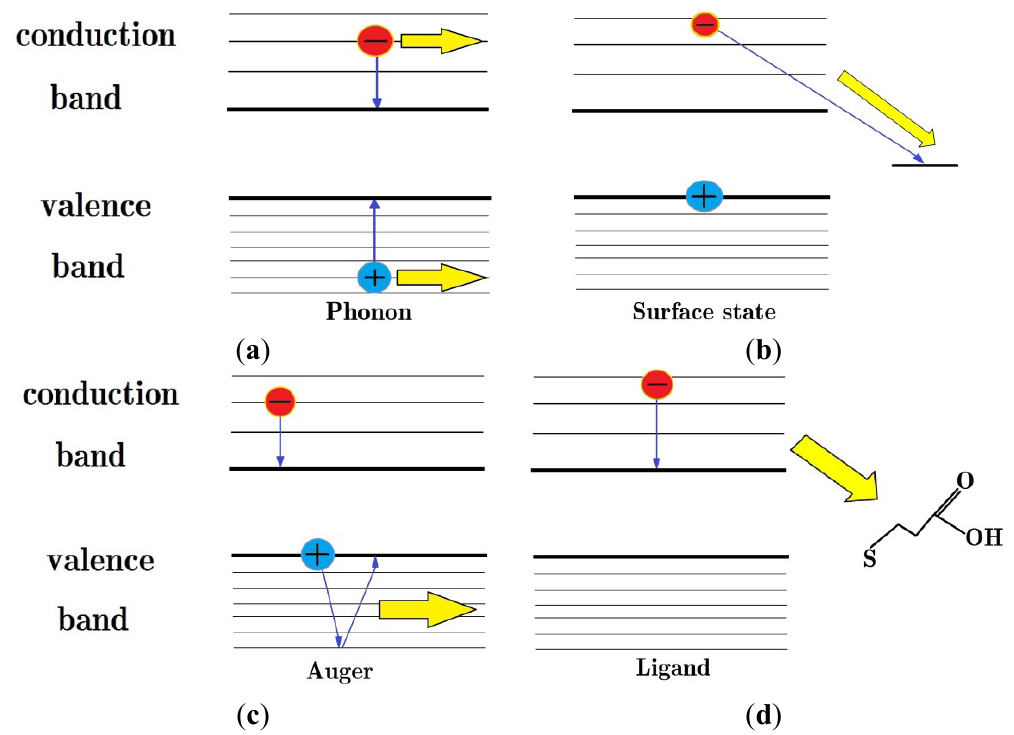
Figure 8. Illustration of the processes which compete with MEG, yellow arrows represent waste energy. ( a ) Phonon emission; ( b ) Electron transfer to a surface state; ( c ) Auger relaxation, where the electron’s excess energy is transferred to the hole which exhibits faster phonon cooling due to the denser band structure of the valence band; ( d ) Transfer of energy to surface ligands through vibrational